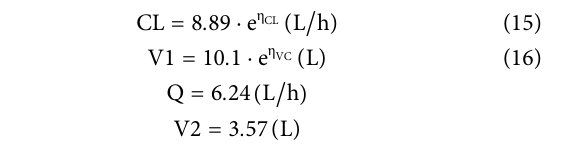
Frontiers in Pharmacology |